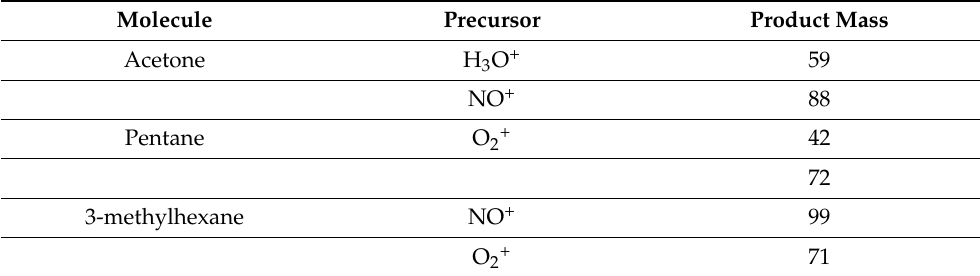
Table 1. Precursor and product mass for each measured